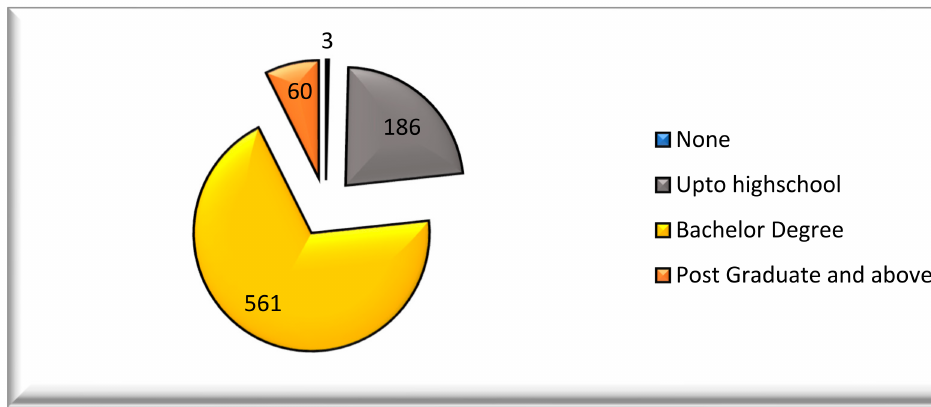
Figure 1. Distribution of education